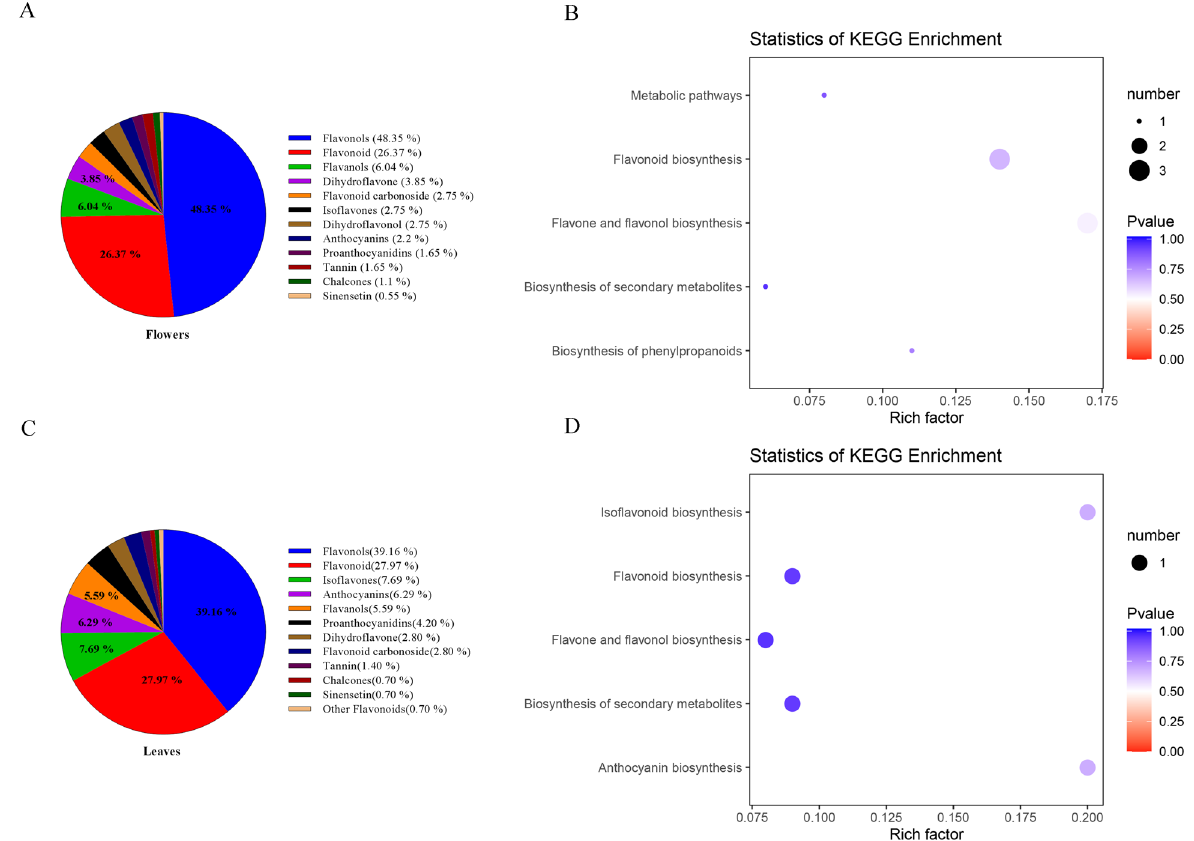
Figure 3. Component analysis of the putatively annotated metabolites and pathway enrichment analysis of the DAMs. (A) In flowers, component analysis of the putatively an-notated metabolites from large flower taxa and small flower taxa. The percentage of the top six metabolites are shown in the graph. The percentage after each compound represents the percentage of the number of DAMs of a certain class of compounds in the total DAMs. ( B) In flowers, metabolic pathway of flavonoids enrichment analysis of the DAMs between large flower taxa and small flower taxa. The x-axis represents the corresponding rich factor of each pathway. The y-axis represents the name of pathway. The color of the dot is p-value, and the closer it is to 0, the more significant the enrichment is. The size of the point represents the number of DAMs enriched in the corresponding pathway. The rich factor is the ratio of the number of metabolites in the corresponding pathway to the total number of metabolites detected and annotated in the pathway. The higher the value of rich factor is, the higher the enrichment degree is. ( C) In leaves, component analysis of the putatively annotated metabolites from large flower taxa and small flower taxa. ( D) In leaves, metabolic pathway of flavonoids enrichment analysis of the DAMs between large flower taxa and small flower